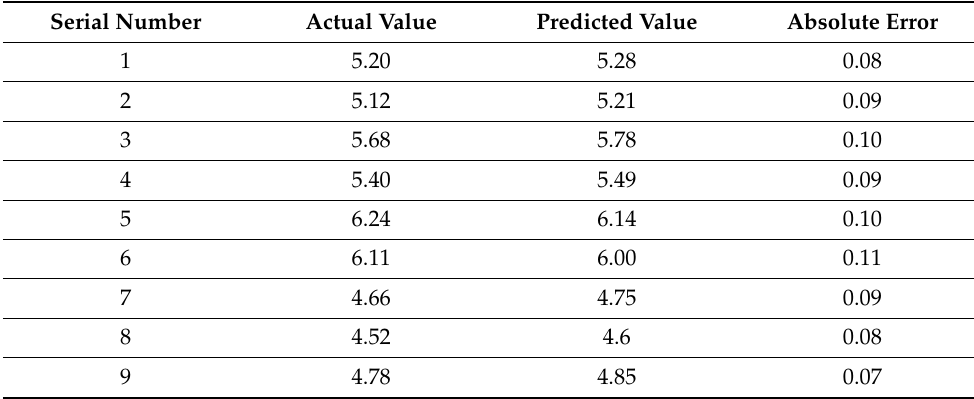
Table 6. Prediction results of the IPSO-LSSVM